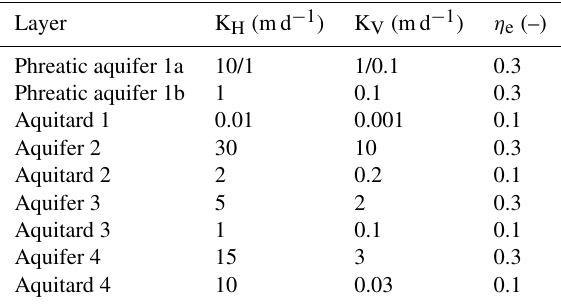
Table 1. Hydrogeologic parameters used in the simulations, where the upper part of the phreatic aquifer (1a: above − 10ma.m.s.l.) was subdivided in two hydrogeological zones (1: fine to coarse sand; 2: clay, loam, and fine